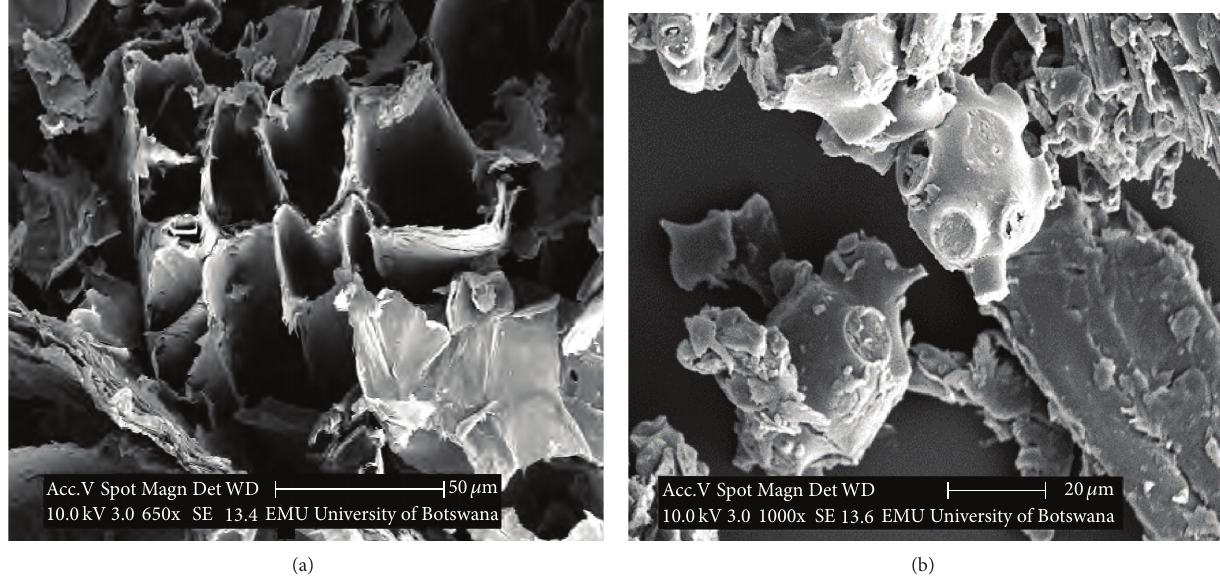
Figure 2: SEM micrographs: (a) Moringa seed pods and (b) Morula nut shells.